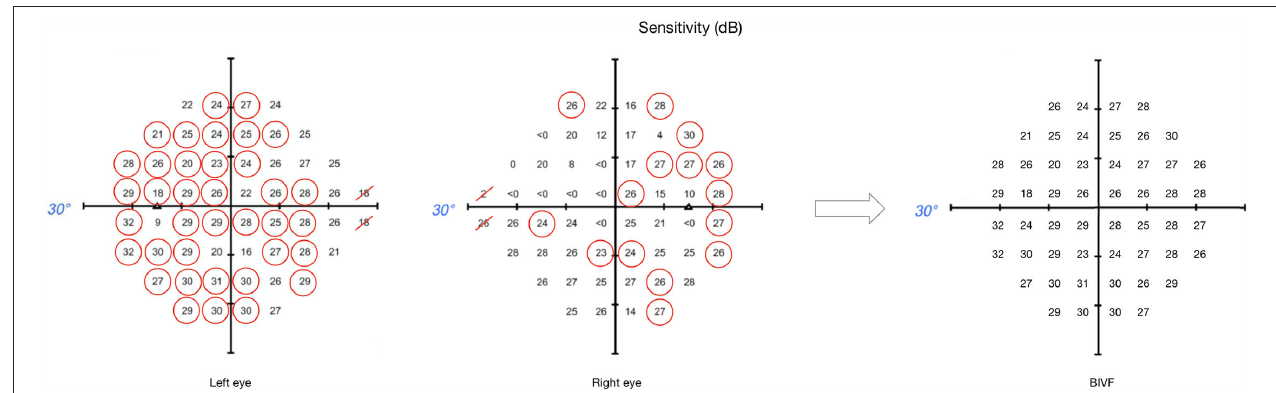
FIGURE 1 | Example of binocular integrated visual field calculation. This image shows the sensitivity maps from the original HFA output, for both left and right eyes respectively, and the resulting map for the BIVF, in case the eccentricity of the visual field is examined up to 30 ◦ away from fixation. For each overlapping location between left and right eye, the highest value was selected (circled in red). The BIVF was calculated as the average of the selected values of each eye’s sensitivity map.